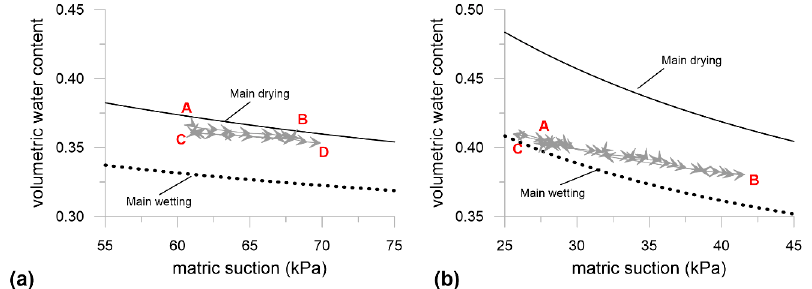
Figure 8. Experimental measurements of matric suction and volumetric water content at 50 cm (symbols) for hysteresis loops representative of different initial state conditions: ( a ) 20 July 2020–11 August 2011 (calibration period); ( b ) 08 November 2011–17 December 2011 (validation period).